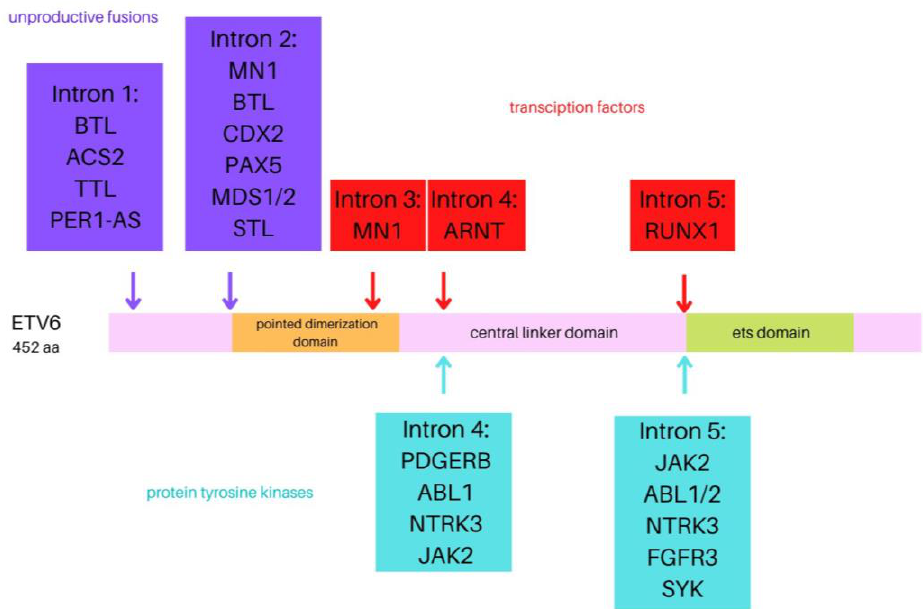
Figure 1. Visual representation of the ETV6 protein with the position of the breakpoints of the various fusion partner genes.